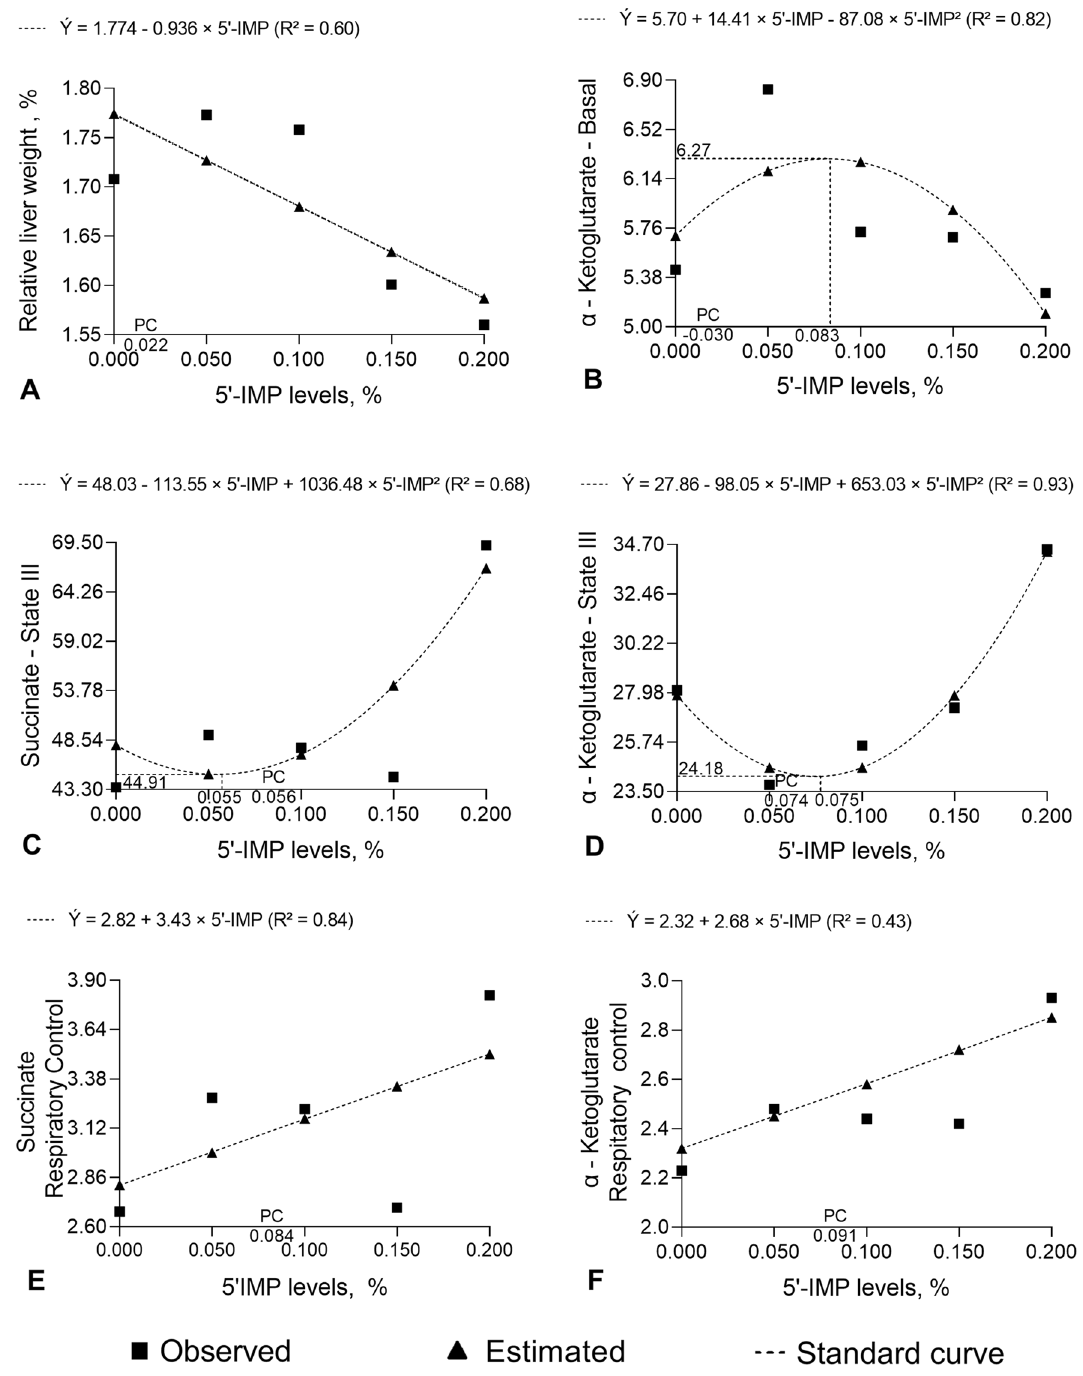
Figure 2. Relative liver weight and oxygen consumption at different states of respiration in mitochondria isolated from the liver of 75–100 kg barrows fed diets containing different levels of inosine-5 ′ -monophosphate (5 ′ -IMP) and a 100 kcal/kg lower metabolizable energy level than the positive control (high-energy) The lean meat yield of pigs fed the negative control diet was lower ( P < 0.001) than that of pigs fed the positive control diet or 5 ′ -IMP-supplemented diets ( P ≤ 0.05). The positive control diet resulted in a lower ( P < 0.020) lean meat yield than the 0.150% 5 ′ -IMP-supplemented diet (Table 3). Lean meat yield was shown to have a quadratic relationship with 5 ′ -IMP level ( P < 0.001): the highest yield (58.79%) was predicted to occur with 0.148% 5 ′ -IMP supplementation (Fig. 5B). The m. longissimus lumborum depth of pigs did not differ significantly ( P > 0.05) between treatments (Table 3). The backfat thickness of pigs fed the negative control diet was lower ( P = 0.002) than that of pigs fed the positive control diet or diets supplemented with 0.050%, 0.100%, or 0.150% 5 ′ -IMP ( P = 0.003, P = 0.009, and P = 0.025, respectively). There were no differences ( P > 0.05) in backfat thickness between positive control